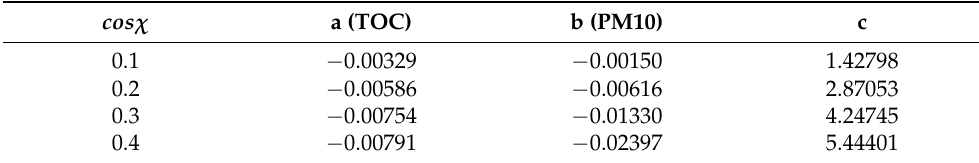
Table 1. Values of the obtained regression